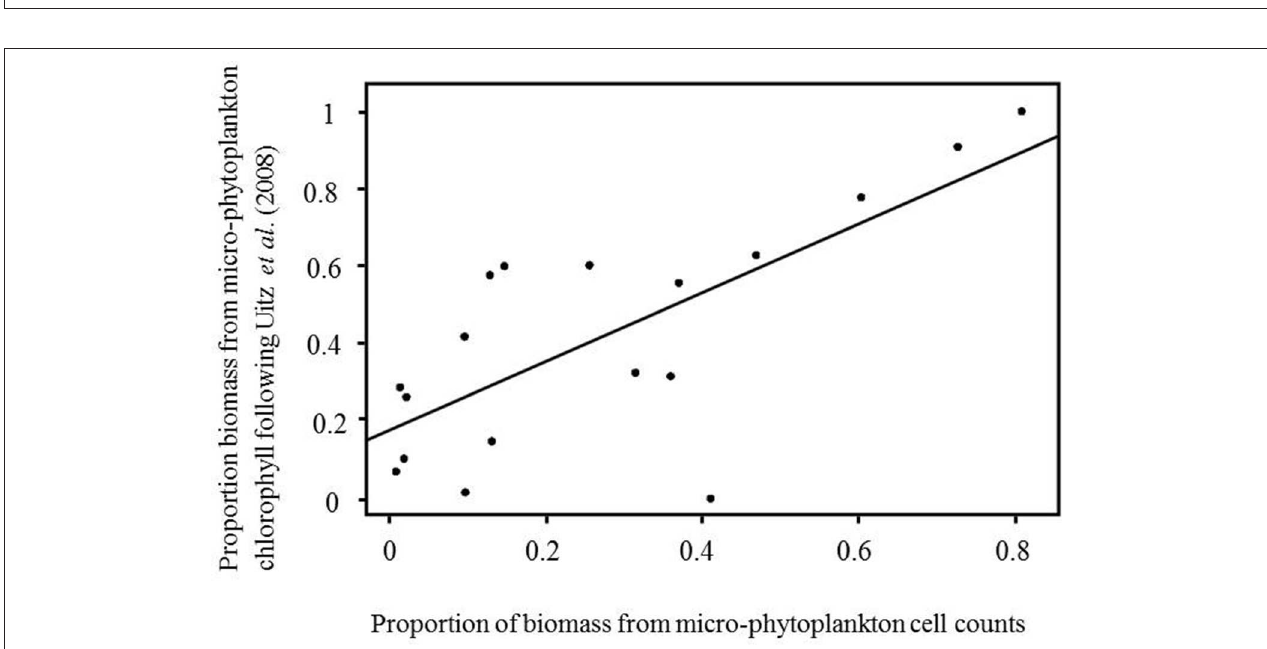
FIGURE 3 | Comparison of the proportion of micro-phytoplankton to total carbon estimated using microscopy counts against the proportion micro-phytoplankton estimated from total chlorophyll following Uitz et al. (2008). Data are from 7m depth during the AMT6 cruise.